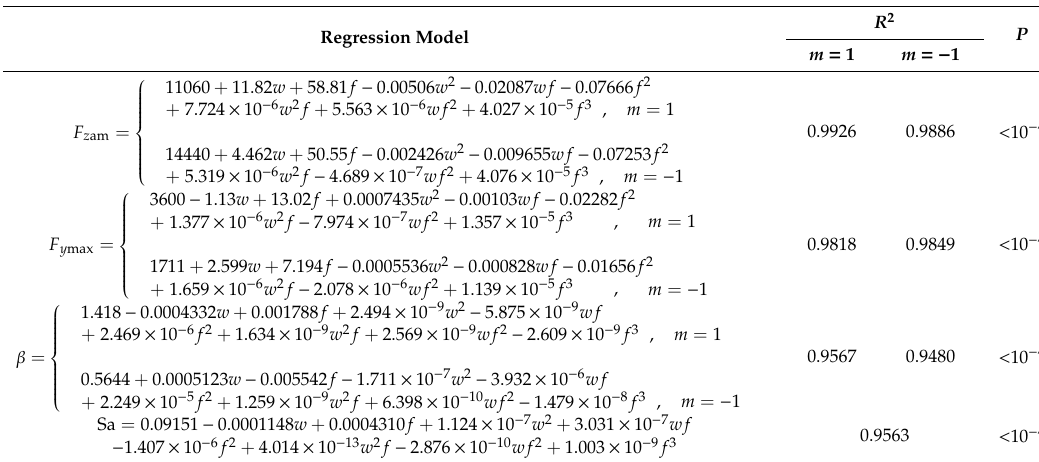
Table 5. Regression models and validation